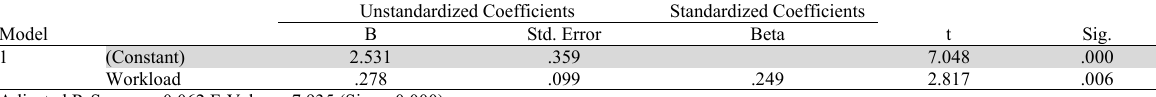
The summary of the results of testing the fourth sub-hypothesis Model